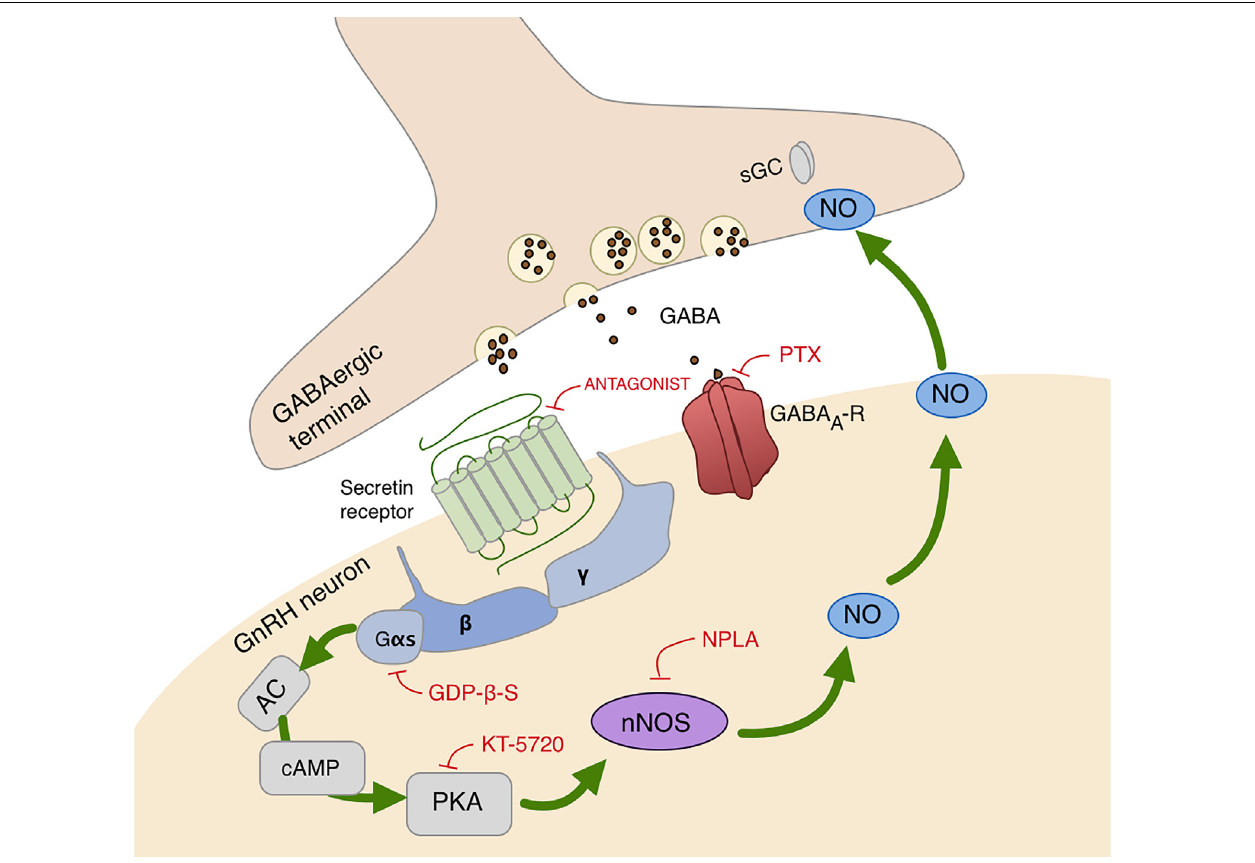
FIGURE 5 | Schematic illustration of secretin receptor signaling in GnRH neurons. Secretin activates cAMP/PKA/nNOS pathway and generates NO that binds to its presynaptic receptor, sGC, located in the GABAergic terminals. This signaling process increases the release of GABA, therefore, facilitates the synaptic inputs to GnRH neurons via GABA A -receptor. AC, adenylate cyclase; cAMP, cyclic adenosine monophosphate; G α s, G β , G γ , G-protein subunits; GABA A -R, GABA A -receptor; PTX, picrotoxin, selective GABA A -receptor blocker; PKA, protein kinase A; KT5720, protein kinase A inhibitor; nNOS, neuronal nitric oxide synthase; NPLA, nNOS inhibitor; GDP- β -S,G-protein inhibitor; sGC, soluble guanylyl cyclase, NO receptor. Red lines depict inhibitory actions, green arrows refer to the signal